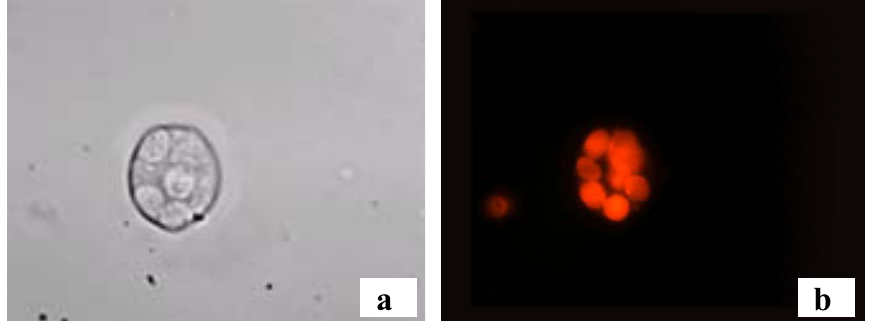
Figure 12. T lymphocytes from a fresh blood sample of a healthy volunteer stained using anti-CD3 mAb labeled with Eterneon TM 394/507 NHS . Light transmission ( a ) and fluorescence ( b ) microscopy images, magnification: